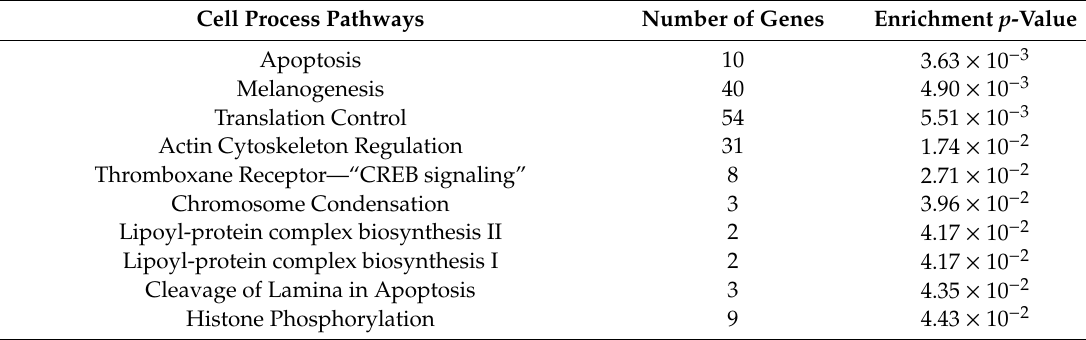
Table 2. Relevant cell process pathways based on p -values in ovarian tissue.